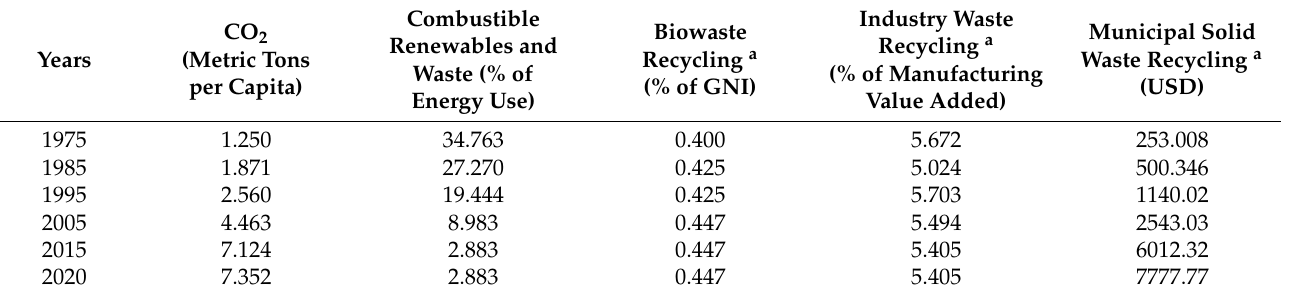
Table 1. Trend Analysis of Carbon Emissions, Waste Generation, and Recycling(1975–2020) in